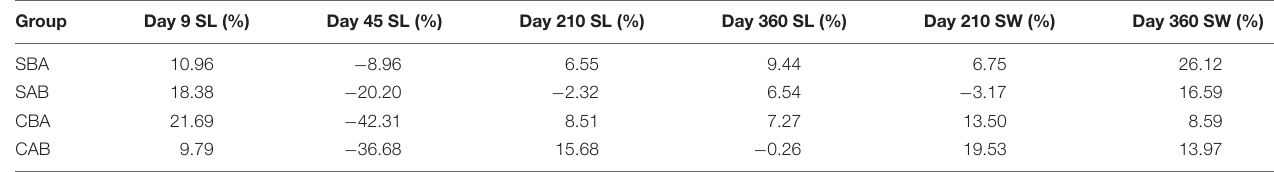
TABLE 4 | Heterosis values for growth of reciprocal hybrid crosses of P. martensii (SL: shell length; SW: shell width). Group